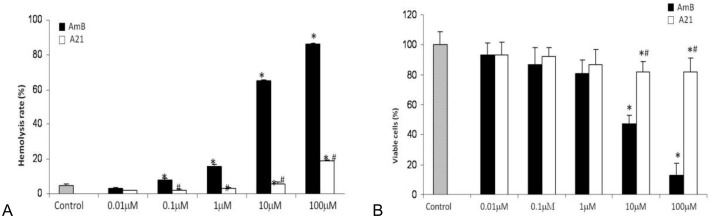
A) Comparative effect in hemolysis of human RBCs by AmB and A21 after 2 h incubation at 37 C (data represented as mean ± SD; n = 8). Significant differences with respect to control or AmB are indicated with *p < 0.05 and #p < 0.05, respectively. B) Changes in the survival of kidney cells HEK-293Q after treatment with different concentrations of AmB (DMSO) and A21 during a 24 h incubation period (control = 100%). The results are presented as means ± SD of 3 independent experiments. *p < 0.05 is the comparison against control value. #p < 0.05 the comparison against AmB.